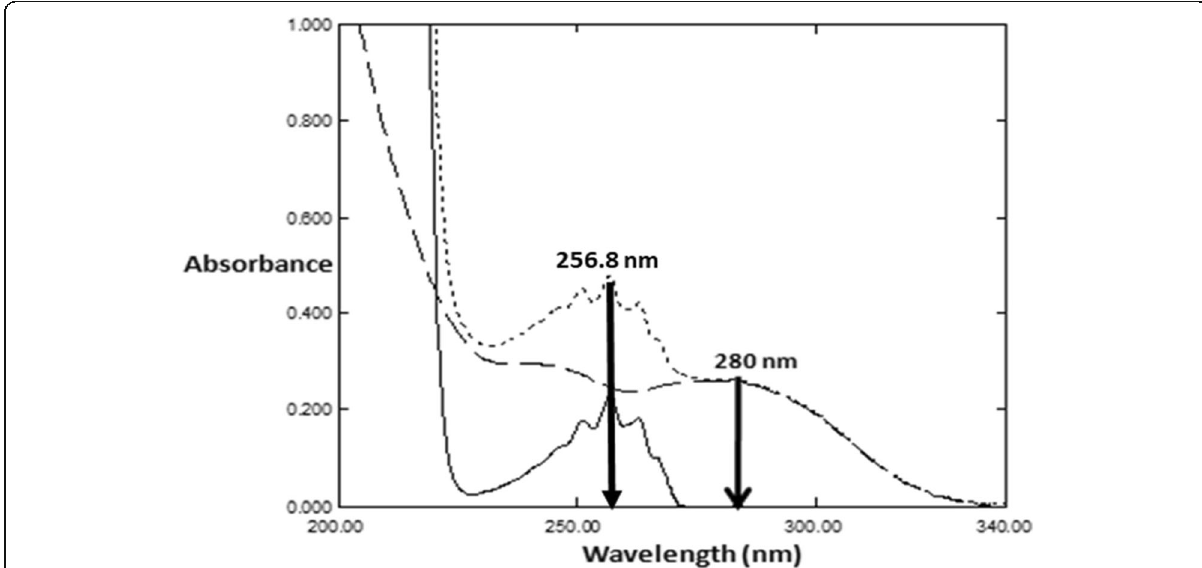
Fig. 2 Zero-order absorption spectra of PSE (s/b a) 240.0 μ g/mL, LOR (s/b b) 10.0 μ g/mL in a wavelength region (200 – 340nm) and their binary mixture (s/b